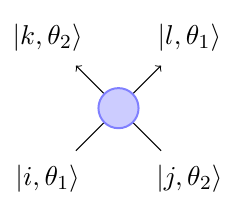
Figure 1 . The basic 2 ! 2 S-matrix elements depend on the rapidities of the incoming and outgoing particles as well as the internal quantum numbers i; j; k; l